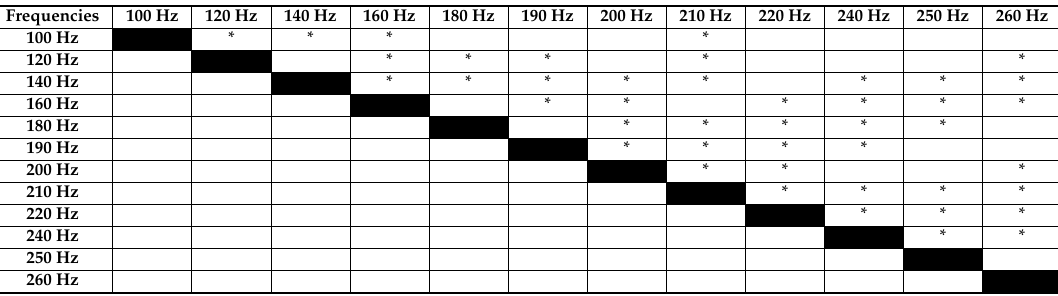
Figure 1. Mean ( ± standard deviation) of mu rhythm reduction rate (through paired t -test) according to localized vibration frequencies. Table 1. Result of paired t -test of the mu rhythm reduction rate, * indicates a statistical significance between vibrational frequencies ( p <